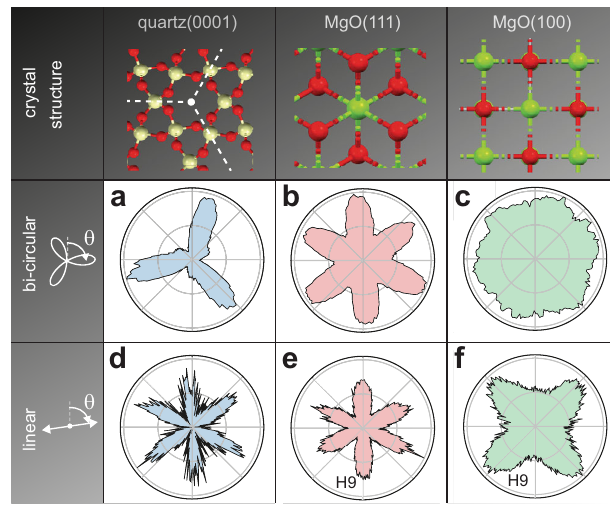
Fig. 2 Bi-circular and linear polarization rotation scans for quartz and MgO. a – c The yield of the eighth harmonic order (H8) as a function of the rotation angle of the threefold fi eld. d – f Yield of H8 as a function of linear polarization angle. For MgO, H8 from linearly polarized drivers is symmetry-forbidden, hence H9 is